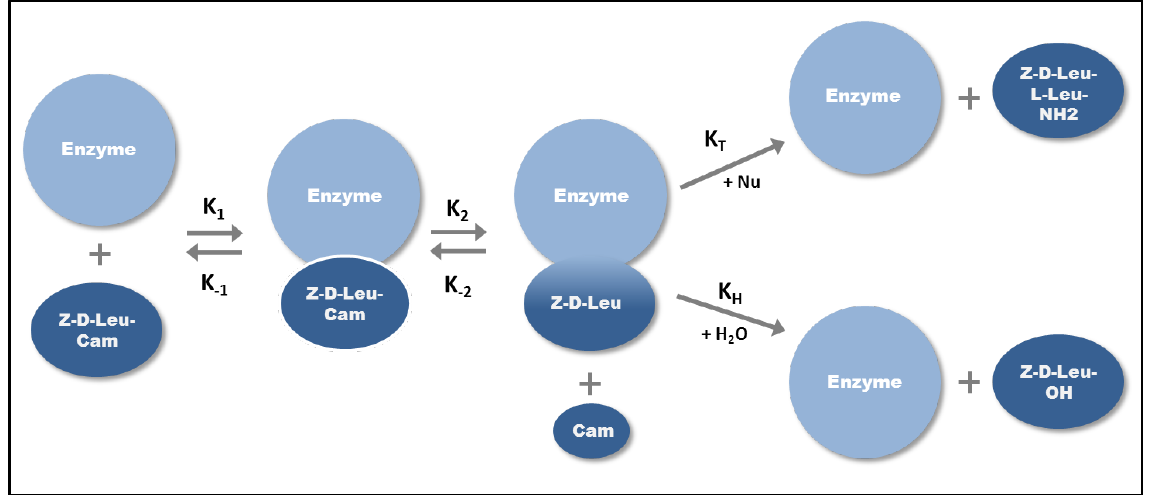
Figure 2. Kinetically-controlled synthesis of Z- D -Leu- L -Leu-NH formation of enzyme-substrate complex (K formed (K ). The intermediate is subjected to the attack from H 2 (Nu). K is the equilibrium constant of hydrolysis, K H transferase